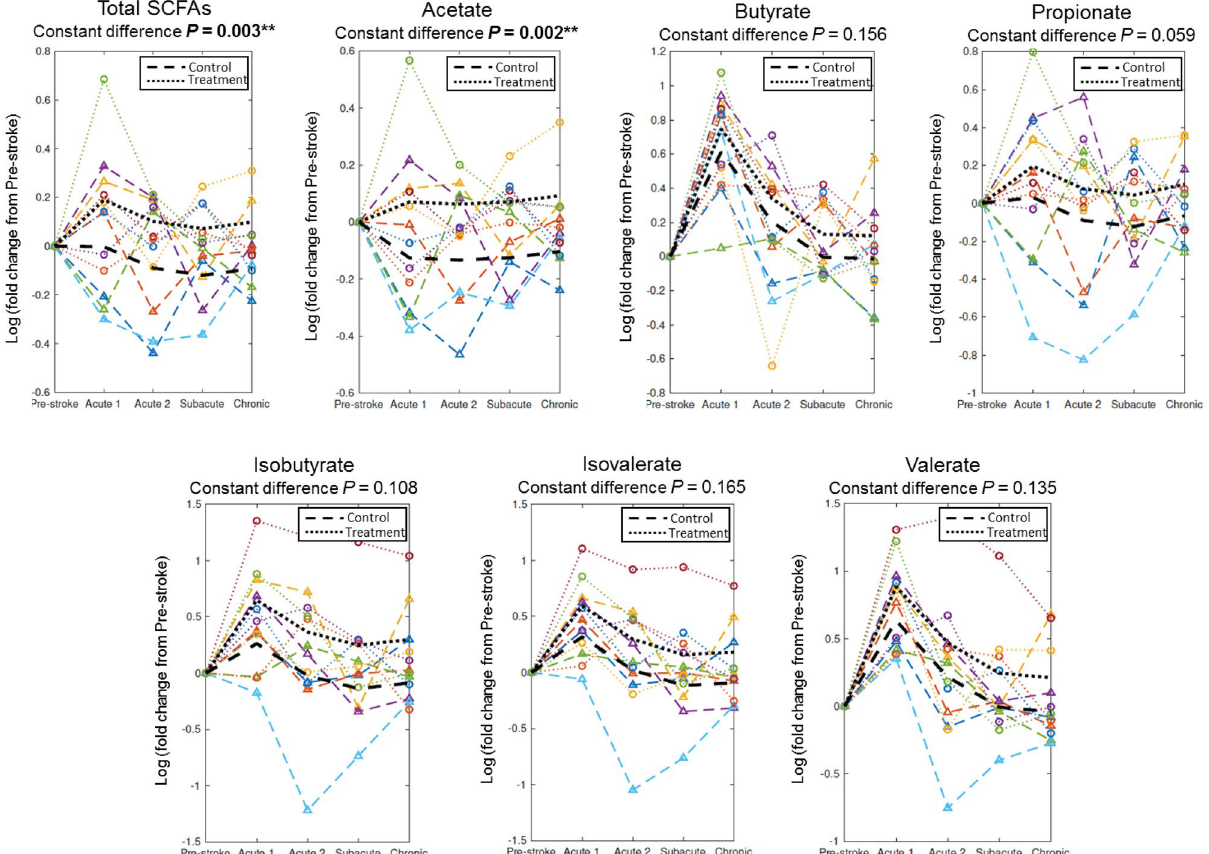
Figure 2. Tan IIA-NP + iNSCs combination therapy increased fecal SCFAs levels in ischemic stroke pigs. Longitudinal changes in fecal SCFAs levels were examined by a multivariate quadratic regression model. Colored lines represent the individual changes in fecal SCFAs of pigs used in this study. The two black lines represent the changes in fecal SCFAs in the control group (n = 6) and the treatment group (n = 6). Changes in fecal total SCFAs and acetate levels from baseline were significantly higher in the treatment group compared to the control group PS. ** P <